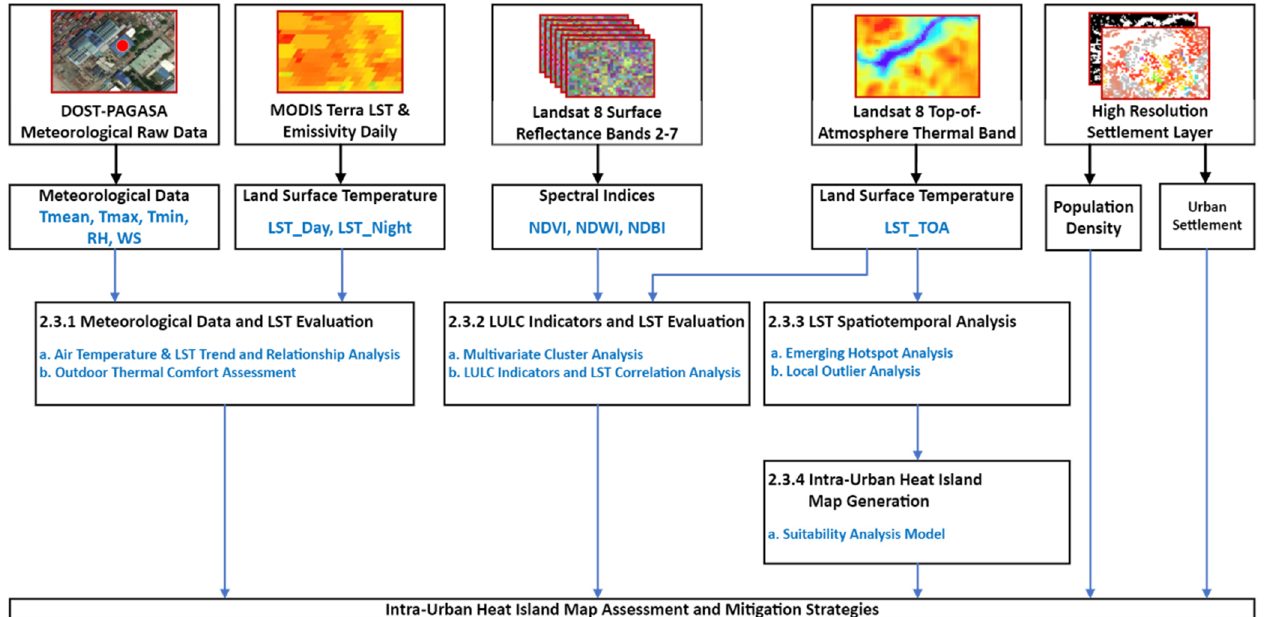
Figure 2. Overview of the overall workflow of the study to assess the IUHI map and provide mitigation strategies.